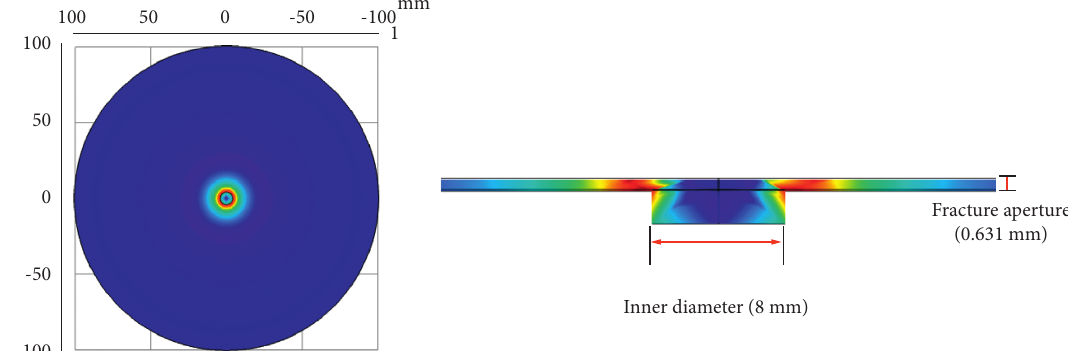
Figure 10: 3D fracture model.